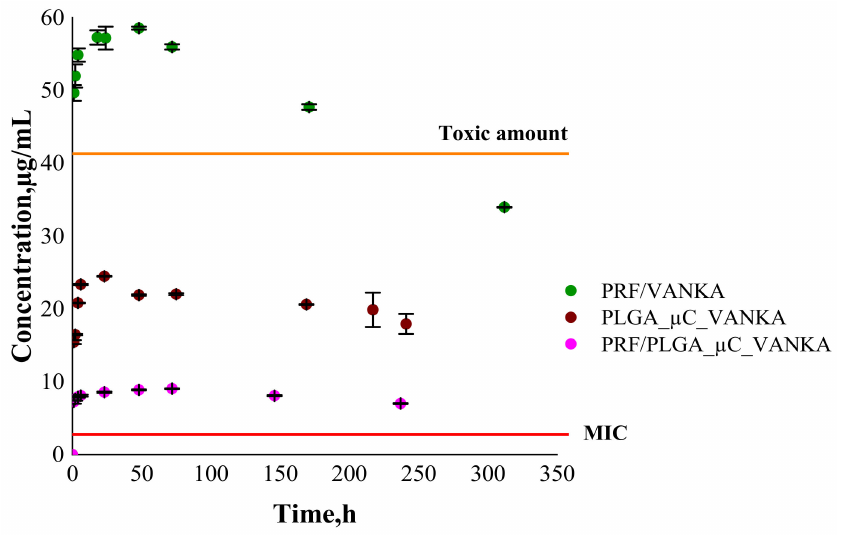
Figure 11. Drug release from PRF/VANKA scaffolds; PLGA_ µ C_VANKA and PRF/PLGA_ µ C_VANKA